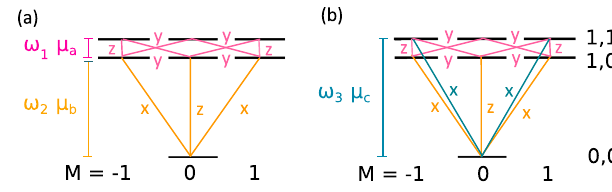
Table 1 Molecular parameter. Rotational constants A , B , C and dipole moments μ a , μ b and μ c for propanediol 2 and carvone 58 , as well as frequencies ω 1 , ω 2 , and ω 3 of the microwave fi elds interacting with the molecules. propanediol Fig. 3 Control fi elds for complete controllability. Choice of four, respectively fi ve, microwave fi elds, which are suf fi cient to ensure evolution operator-controllability ( a ) and enantio-selective evolution operator- controllability ( b ) in the rotational subsystem consisting of the asymmetric top states J ¼ 0 ; τ ¼ 0 ; M ¼ 0 j i , J ¼ 1 ; τ ¼ 0 ; M j i . and J ¼ 1 ; τ ¼ 1 ; M j i , with quantum numbers J , τ , and M . The orange and pink lines in a indicate the four fi elds which yield complete controllability of this subsystem for a single enantiomer. The polarization of the fi elds is denoted by x , y , and z , and μ a , μ b , and μ c are the Cartesian components of the dipole moment responsible for the transitions indicated by the vertical bars. The additional fi eld which is required for enantio-selective control is indicated in b by turquoise lines. The frequencies ω 1 , ω 2 , and ω 3 of propanediol are given